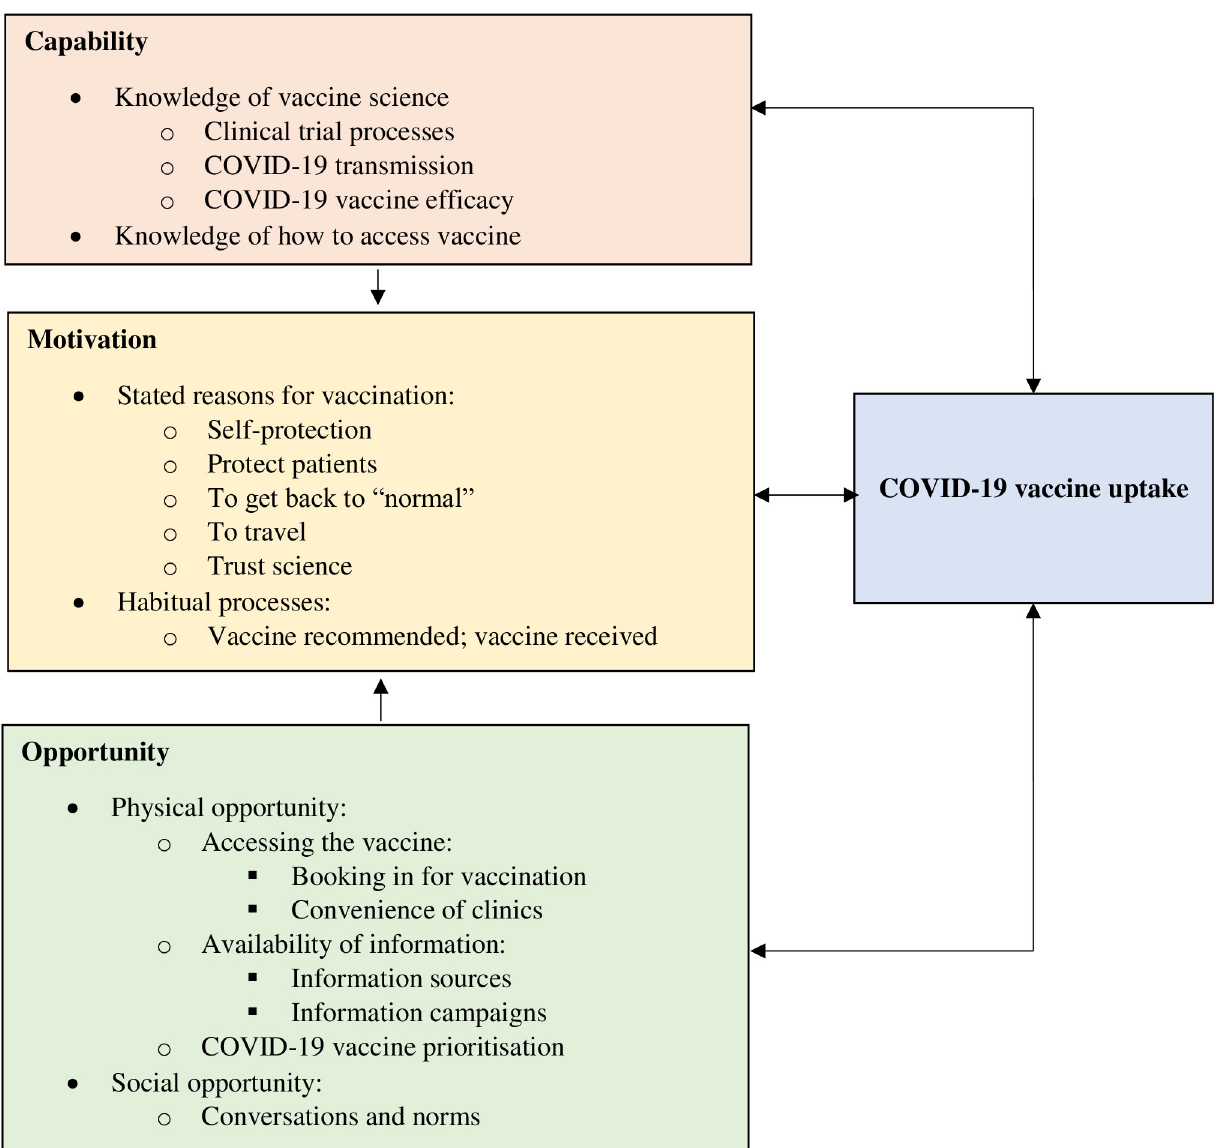
Fig 1. Health care workers capability, opportunity, and motivation to be vaccinated against COVID-19. The arrows depict the way in which each factor influences the other.